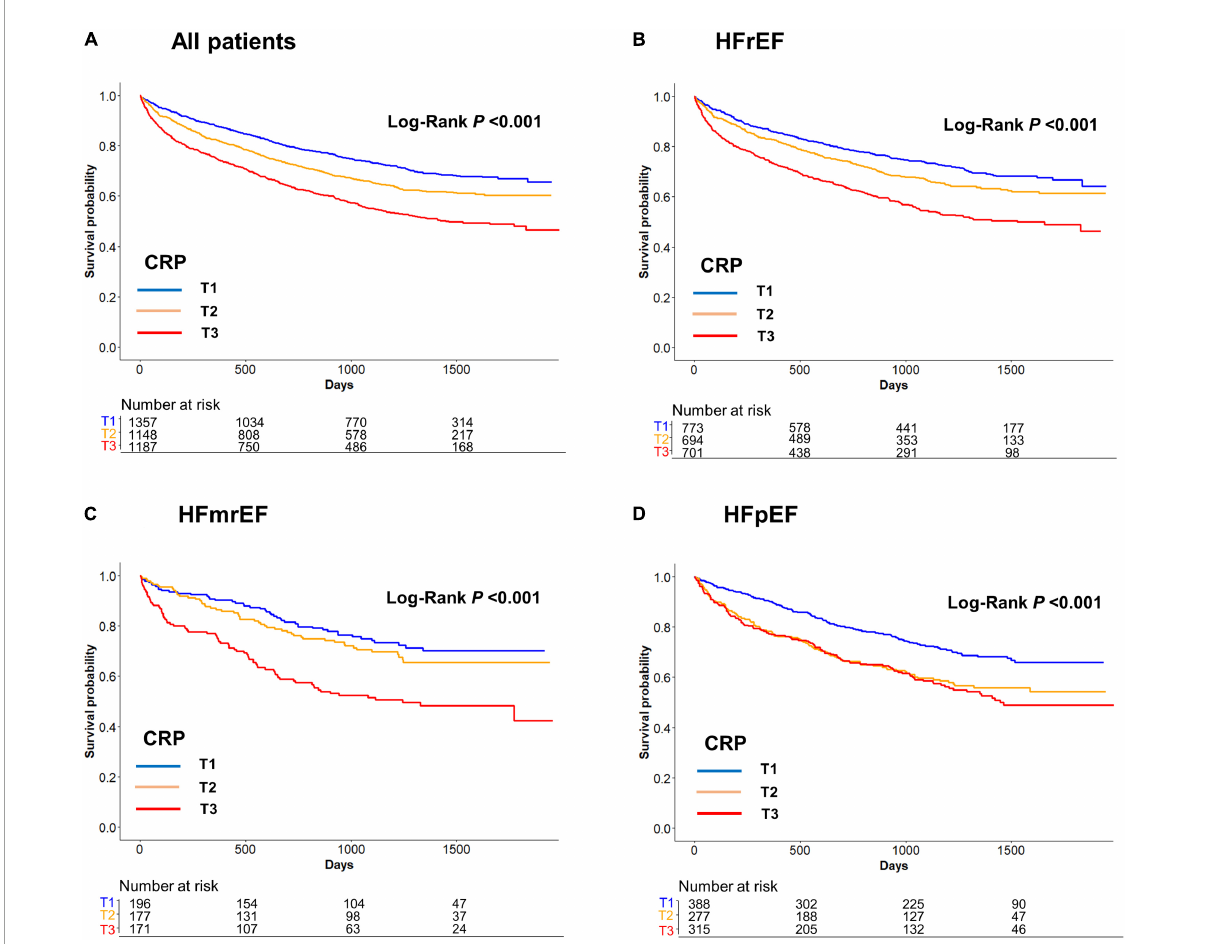
FIGURE2 (A) All patients, (B) HFrEF, (C) HFmrEF, and (D) HFpEF. Post-discharge mortality according to the C-reactive protein (CRP) tertiles. Post-discharge mortality increased with an increase in the CRP tertiles in HFrEF, HFmrEF, HFpEF, and whole population. CRP, C-reactive protein; HFmrEF, heart failure with mild reduced ejection fraction; HFpEF, heart failure with preserved ejection fraction; HFrEF, heart failure with reduced ejection